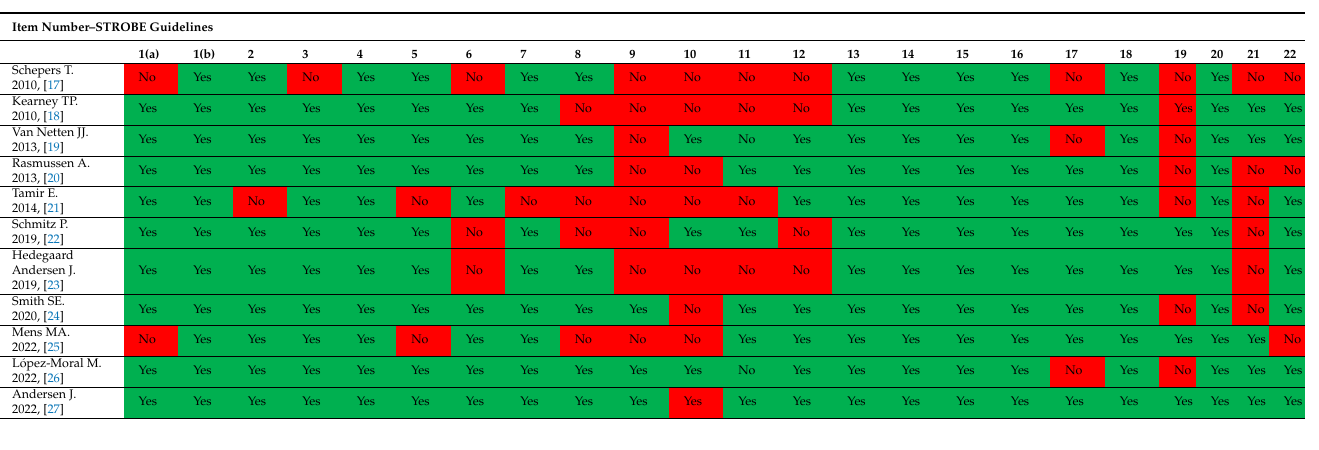
Table 2. The overall rating for Strengthening the Reporting of Observational Studies in Epidemiol- ogy